Question: How would you classify this visualization?
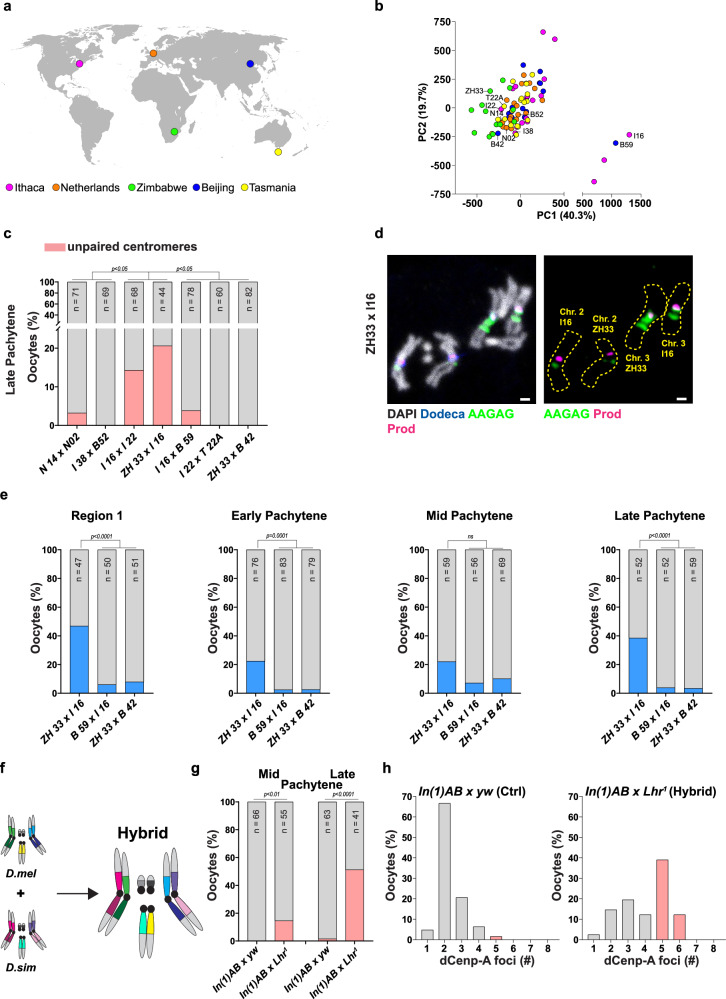
Answer: histogram